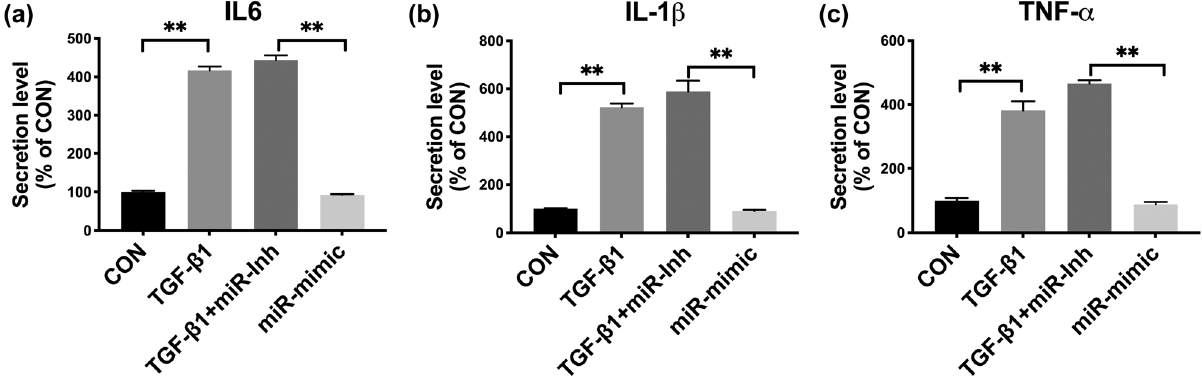
Figure 5: Overexpression of miR - 29c - 3p inhibits in fl ammation. ( a ) IL - 6, ( b ) IL - 1 β , and ( c ) TNF - α in NRK - 49F cells treated with TGF - β 1 ( 10 ng/mL ) , TGF - β 1 with miR - 29c - 3p inhibitor ( miR - Inh ) , and miR - 29c - 3p mimic, all for 48 h before measurement using ELISA ( * P < 0.05; ** P < 0.01 )